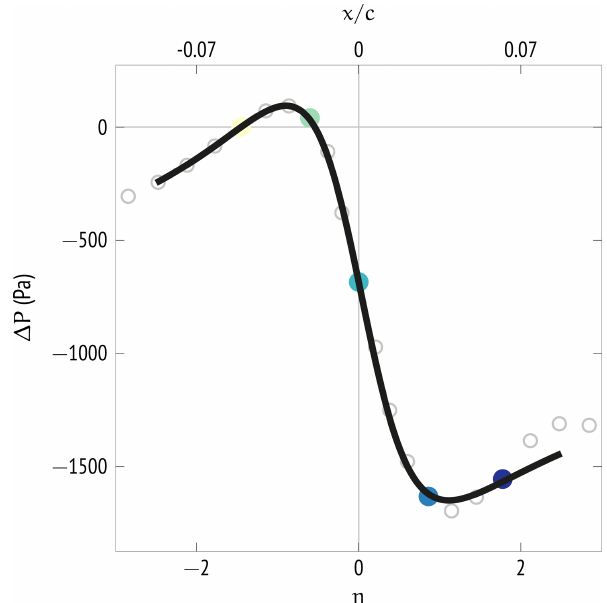
Figure 10. Pressure distribution at the leading edge. Coloured points represent the values from the differential pressure sensors shown in Fig. 9. The other empty circles represent values from other pressure points. The thick black line is the result of an inviscid flow passing a parabola modelling the leading